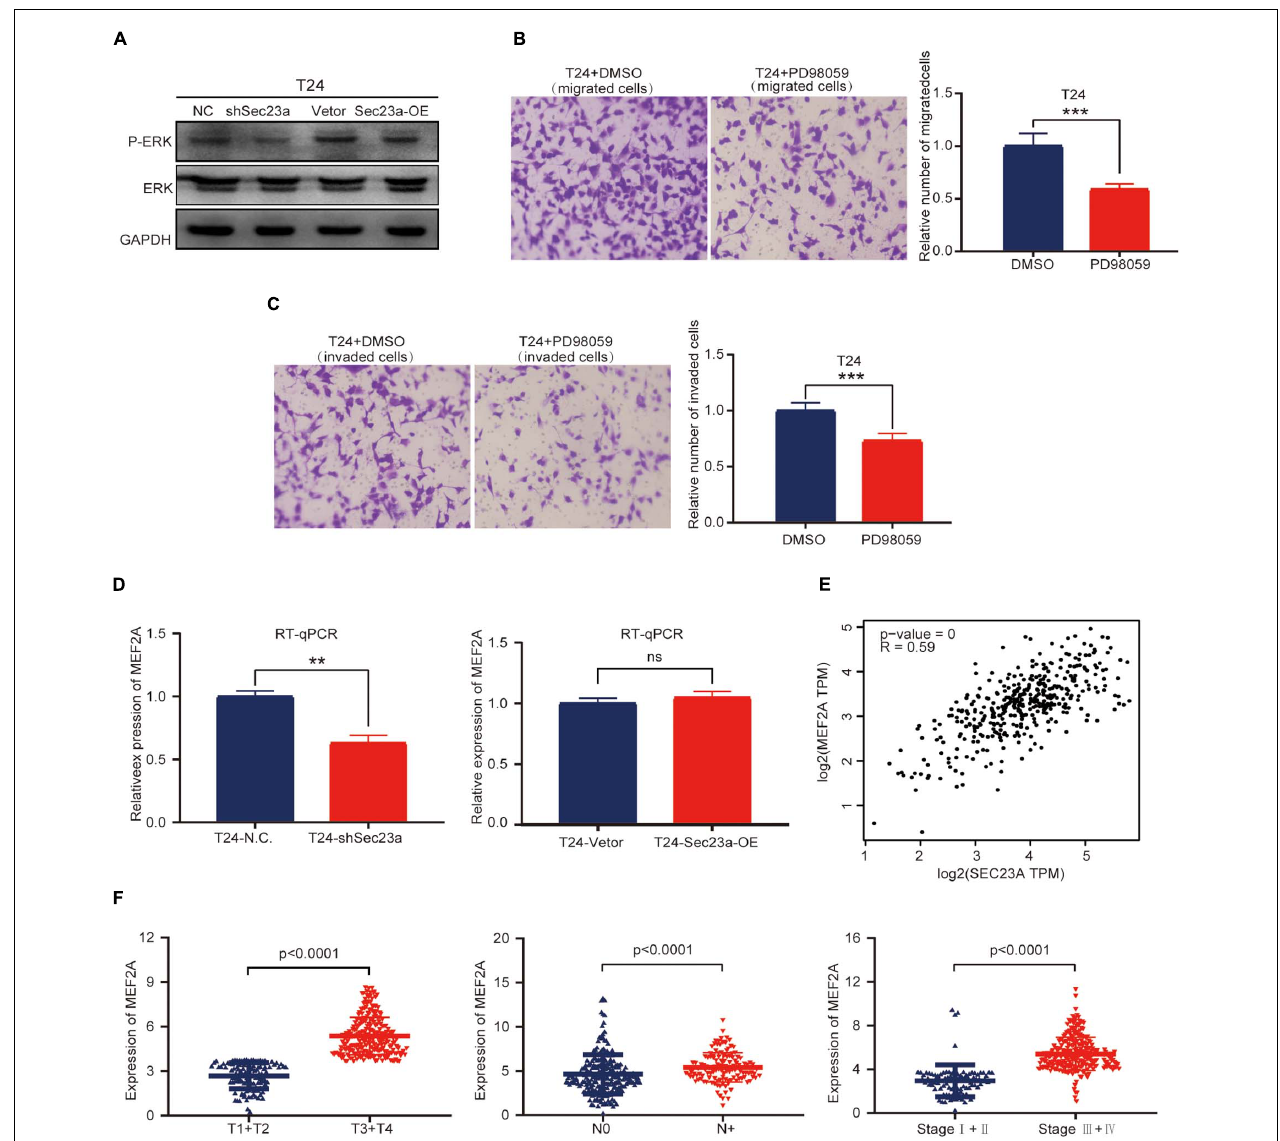
FIGURE 6 | SEC23A augments ERK signaling activation in T24 cells in vitro . (A) Western-blotting analysis of p-ERK in T24 vs T24-shSEC23A, and T24 vs T24-SEC23A-OE cells. (B) Transwell migration assay (*** p < 0.001); (C) Transwell invasion assay (*** p < 0.001). (D) ) RT-qPCR measurement of mRNA expression of MEF2A in T24 and T24-shSEC23A cells (** p < 0.01, left ); and in T24 and T24-SEC23A-OE cells ( right ). (E) SEC23A expression level significantly correlated with MEF2A by GEPIA. (F) Association between MEF2A and clinical-pathological